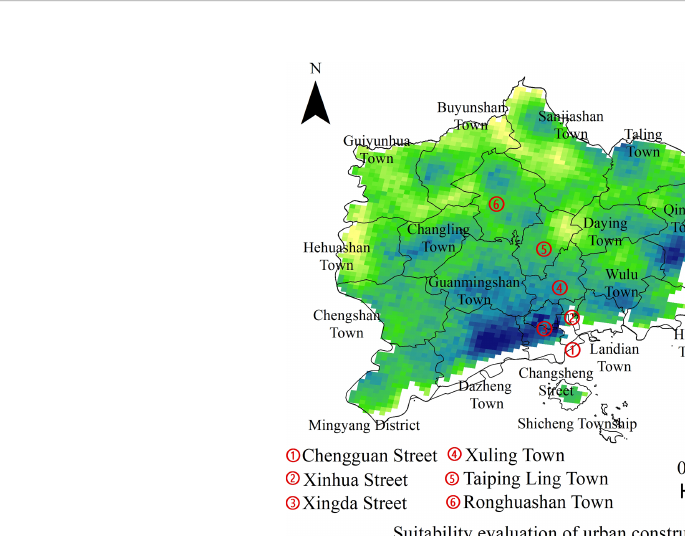
FIGURE 4 Suitability evaluation of urban